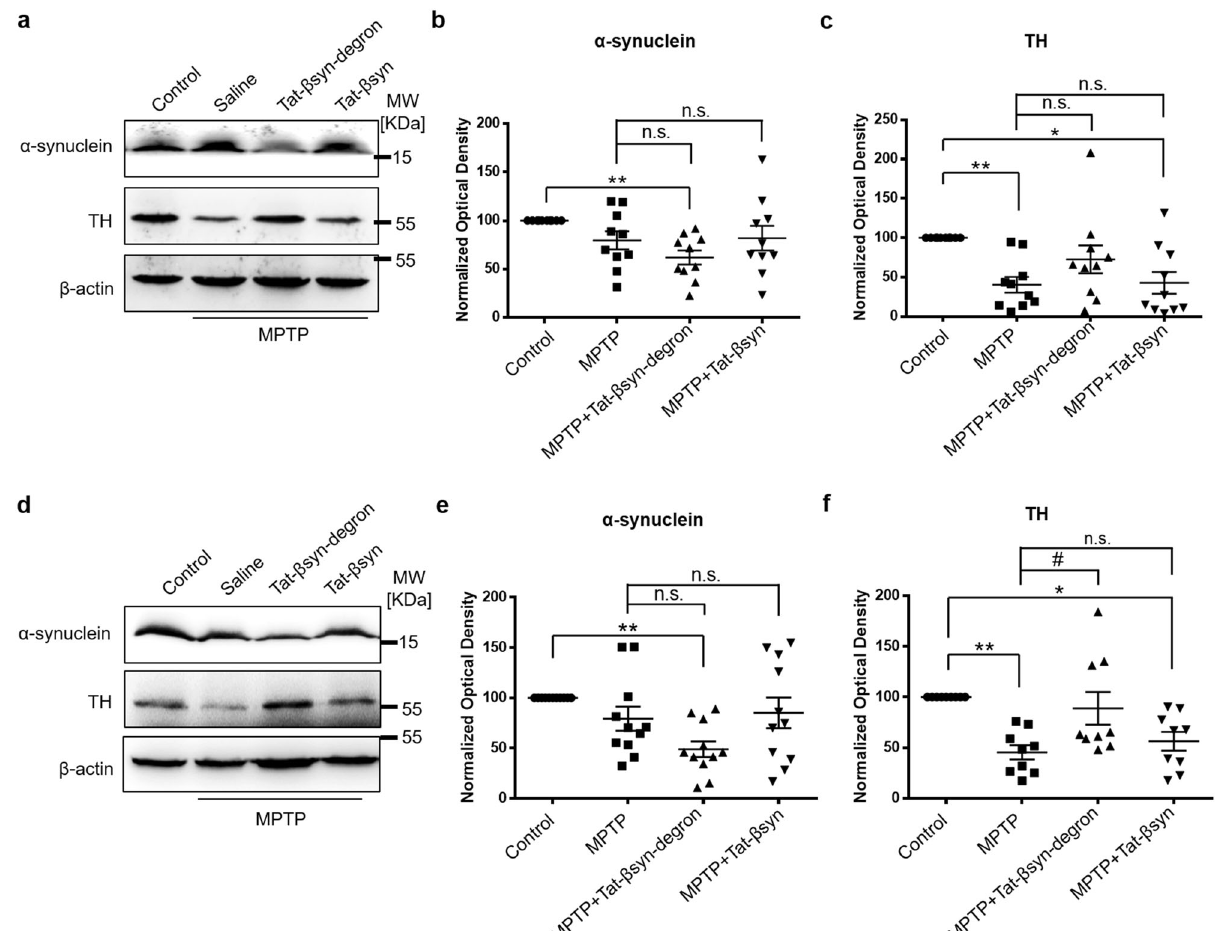
Fig. 6 Tat- β syn-degron peptide-mediated knockdown of α -synuclein protects against parkinsonian toxin MPTP-induced TH protein decrease. a – f